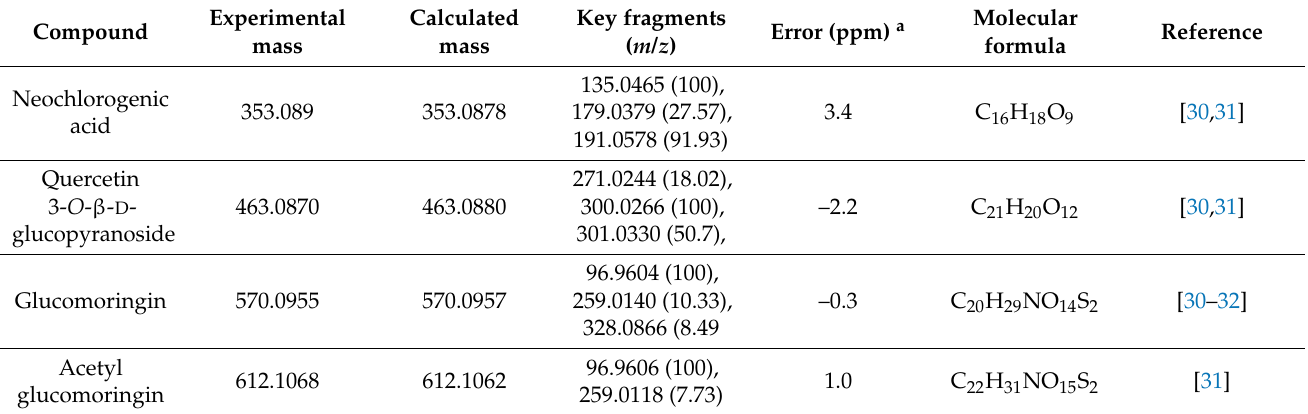
Table 2. Tentative compounds identified in water extract of M. oleifera leaves from Salento (MLES) by HRMS under negative ([M − H] – )